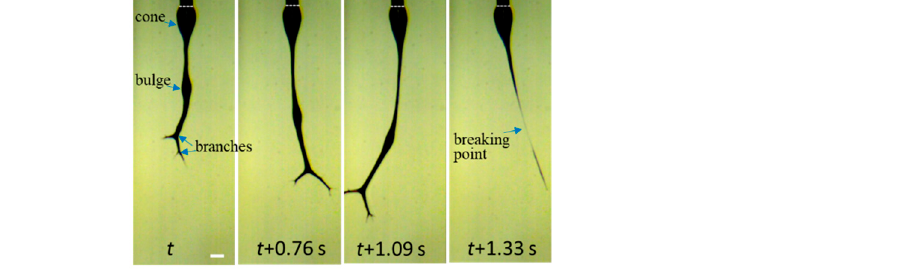
Figure 17. Four snapshots recorded by high-speed video to elucidate the details of jet breaking for the 10 wt% a-PNIPAM aqueous solution electrospun at T solution = 28 °C. The scale bar is 0.64 mm.